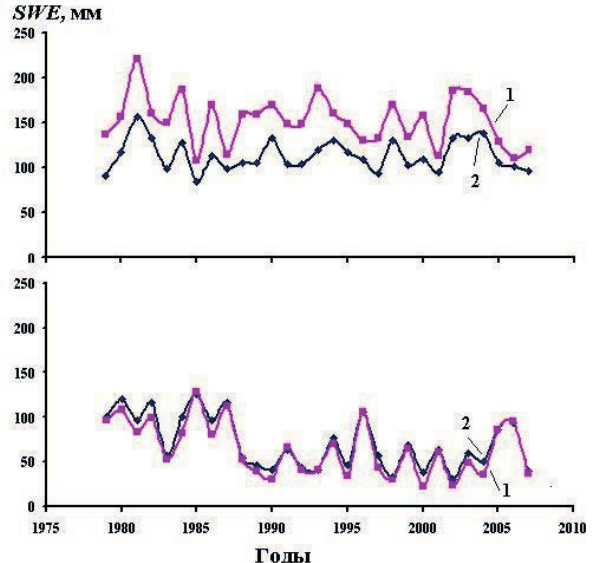
Fig. 5 The basin of the Barents and White seas: differences between the maximal SWE values of forested (1) and open (2) area – in situ (top) and estimated (bottom) data